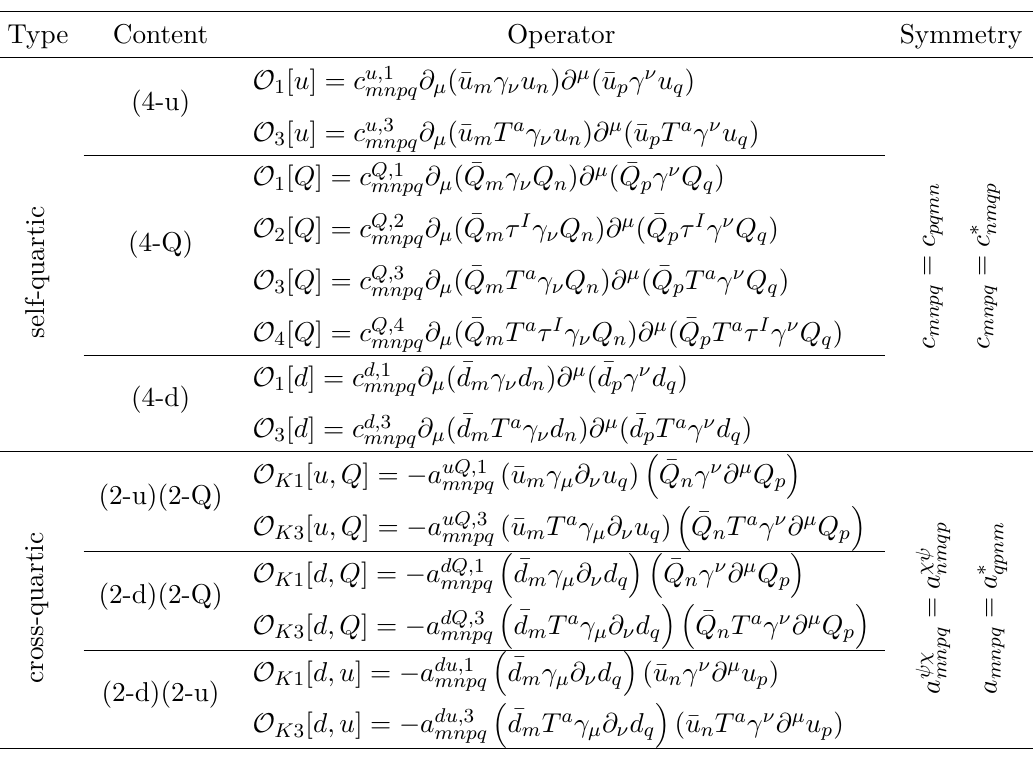
Table 2 . List of independent self-quartic and cross-quartic operators. T a are the SU(3) C QCD generators and τ I = σ I are the SU(2) EW L 2